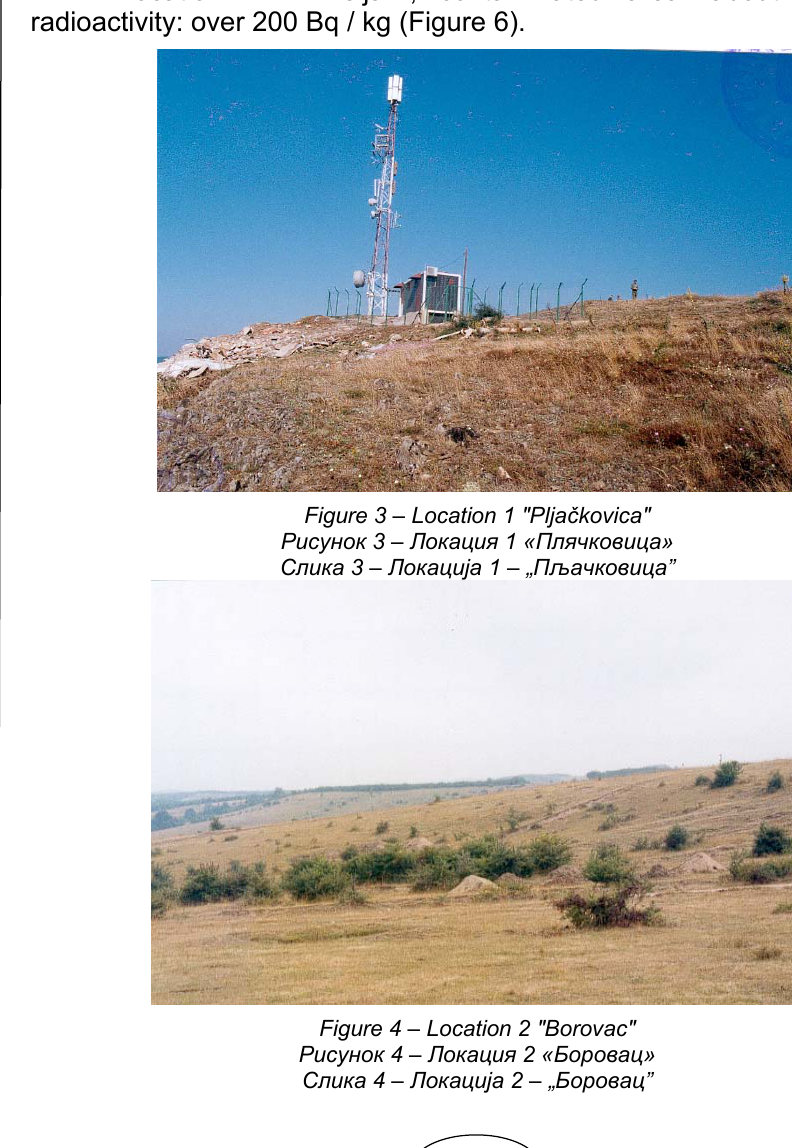
Figure 4 – Location 2 "Borovac" Рисунок 4 – Локация 2 « Боровац » Слика 4 – Локација 2 ‒ „ Боровац